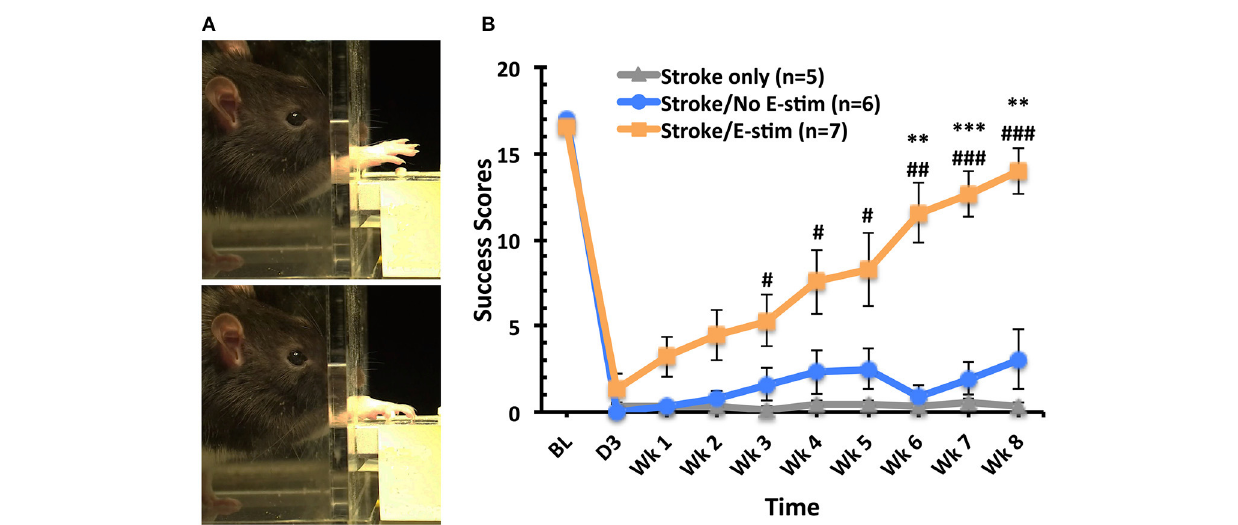
FIGURE 4 | Skilled forelimb reaching task analysis. (A) Sequential frames of the skilled forelimb reaching task performed by an adult rat grasping a sugar pellet. (B) Success scores for reaching task (out of 20 reaches) across time. No difference between groups at baseline. Marked deficits in successfully obtaining pellets with the stroke-impaired limb were apparent 3 days post-op (before treatment) with no significant difference between groups. Rats receiving electrical stimulation showed significant overall improvement of the skilled forelimb reaching test when compared to stroke only and stroke with sham stimulation (two way repeated-measure ANOVA, main effect time p < 0.0001, main effect treatment p < 0.0001, interaction p < 0.001). Weekly comparison showed that animals receiving electrical stimulation exhibited significant improvement in the success scores than the Stroke only group (# p < 0.05 at week 3, 4, and 5, ## p < 0.01 at week 6, ### p < 0.001 at week 7 and week 8) and Stroke/No e-stim group (** p < 0.01 at week 6 and 8, *** p < 0.001 at week 7) and the improvement persisted until the end of the study. There was no difference between two control groups at any time point (Tukey’s post hoc analysis, error bars indicates ±